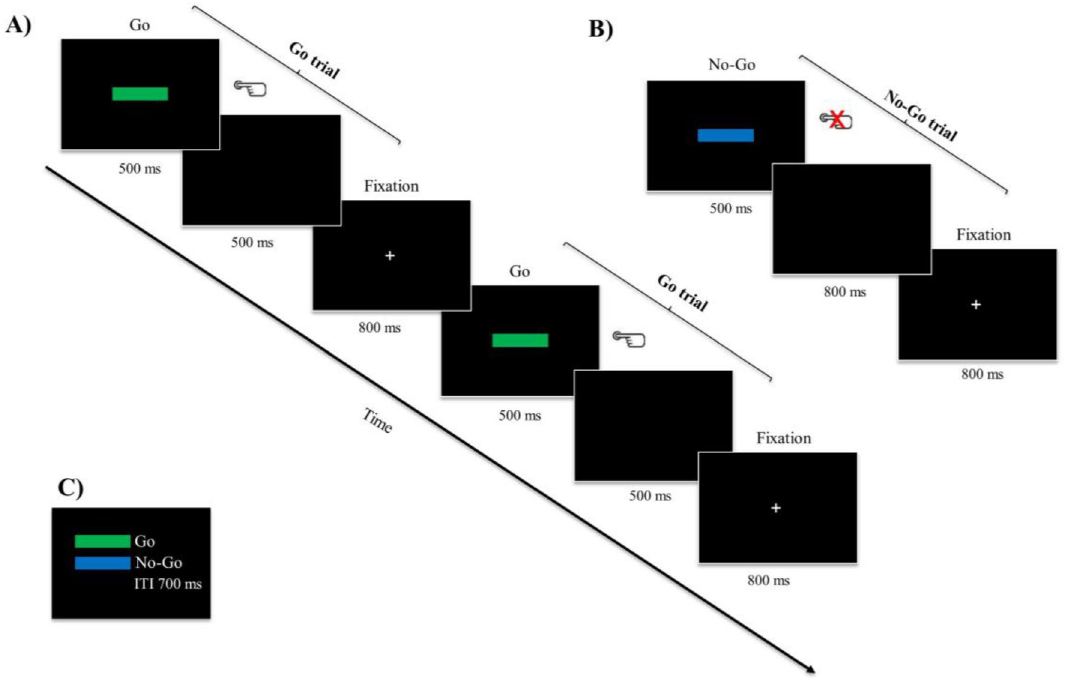
Figure 1. Go/No-Go task. ( A ) The procedure for go and ( B ) no-go trials was identical, apart from the instruction to press spacebar after the presentation of go stimuli and to withhold a response after no-go stimuli. After 500 ms of stimuli, a blank screen appeared for 500 ms. A fixation point was shown for 800 ms. ( C ) Illustrations of go- and no go stimuli. An inter-trial interval (ITI) of 700 ms was used. The Go/No-Go task was administered with Inquisit 5 (Millisecond Software,